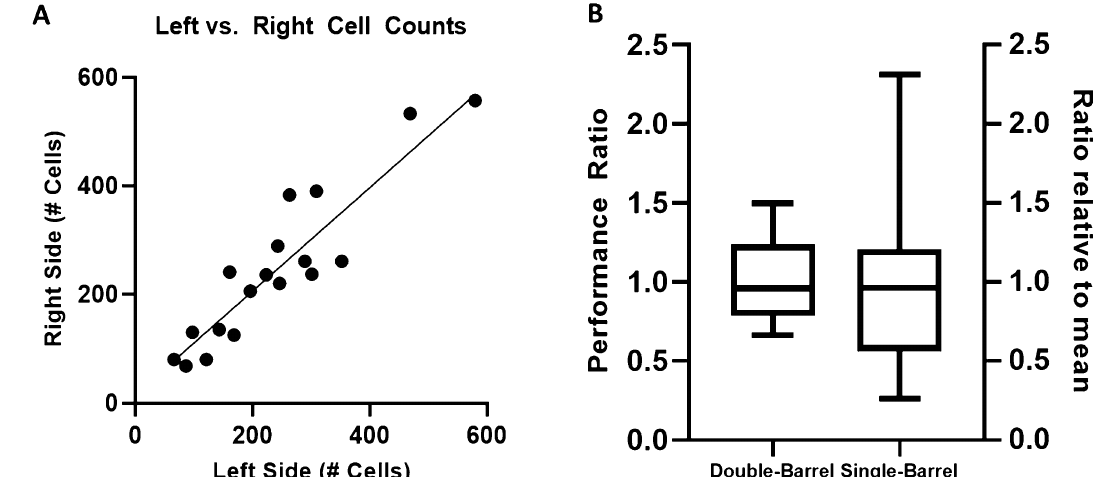
Figure 2. Comparison of GFP-expressing cell numbers from onion tissue bombarded with a single- or double- barreled biolistic device. ( A ) Scatter plot comparing the number of fluorescent cells on the left and right side of a sample when the treatment is identical. The cell counts from both sides had a linear correlation with a slope of 0.95 and coefficient of determination ( R 2 ) of 0.79; ( B ) box plots demonstrating the effect of the double-barrel on controlling for sample variation. The left box plot shows the performance ratio (experimental side/control side) of the same samples from ( A ) (n = 21) after applying the internal control to each sample. The right box plot shows the same data as if they were single-barreled shots, with the number of cells shown as a ratio to the mean (251 cells) for comparison. Box plots show the full range and the inner quartiles. Standard deviations are 0.26 for double-barrel, and 0.52 for